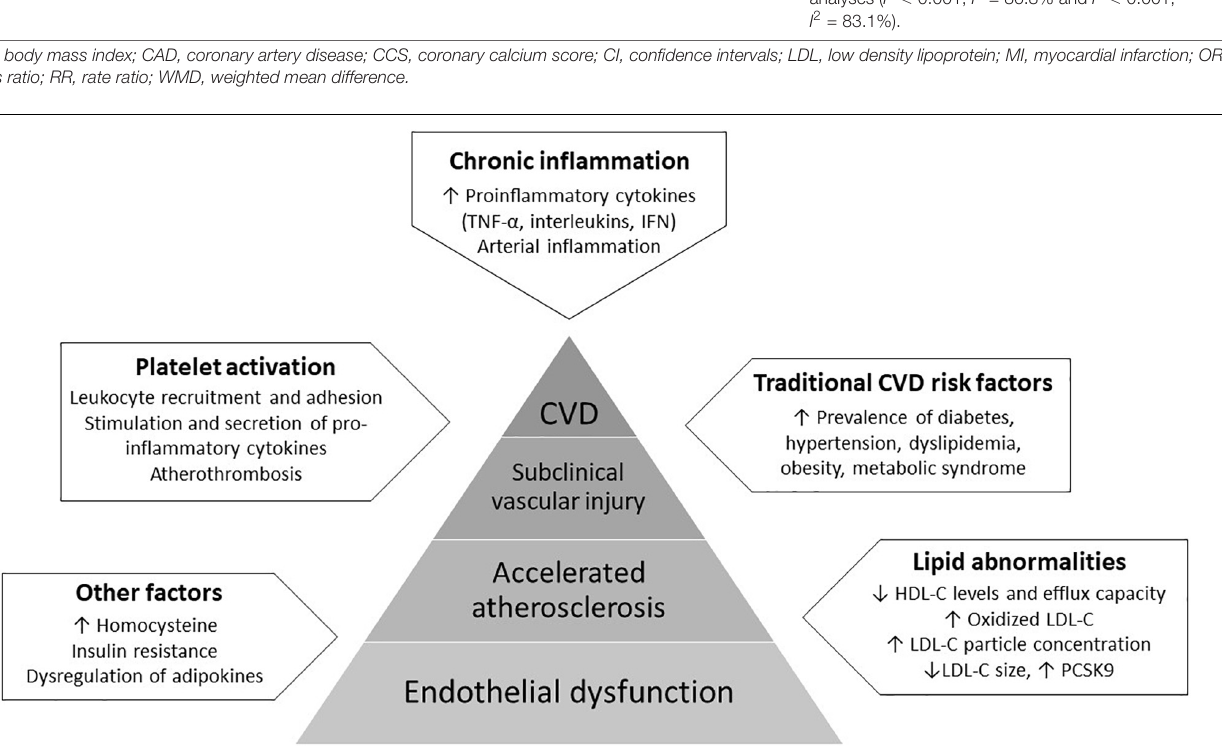
through standard lipid measurements (25). Inflammation